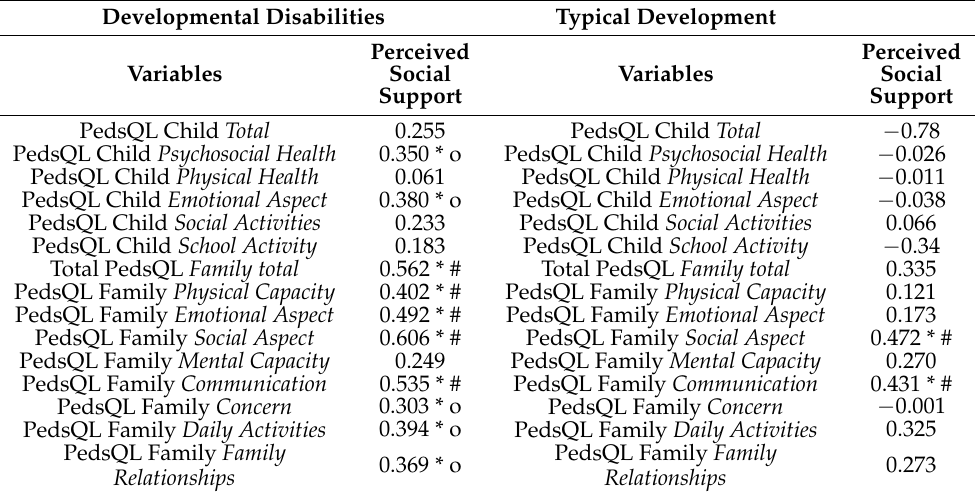
Table 4. Correlation between perceived social support with caregiver’s QoL and child’s QoL for the children with DD and TD and their